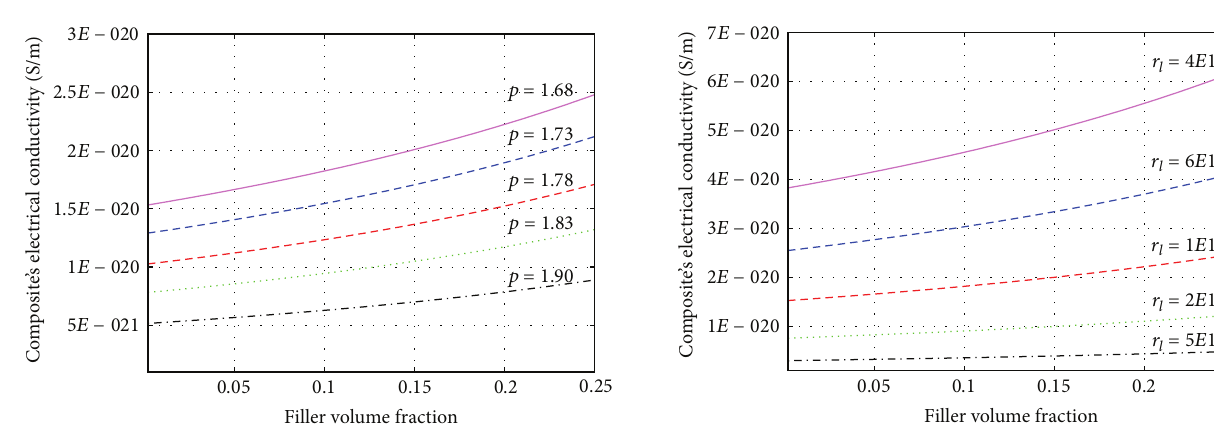
Figure 11: DC electrical conductivity of the nanocomposite at varying the conductivity of the matrix (McLachlan’s